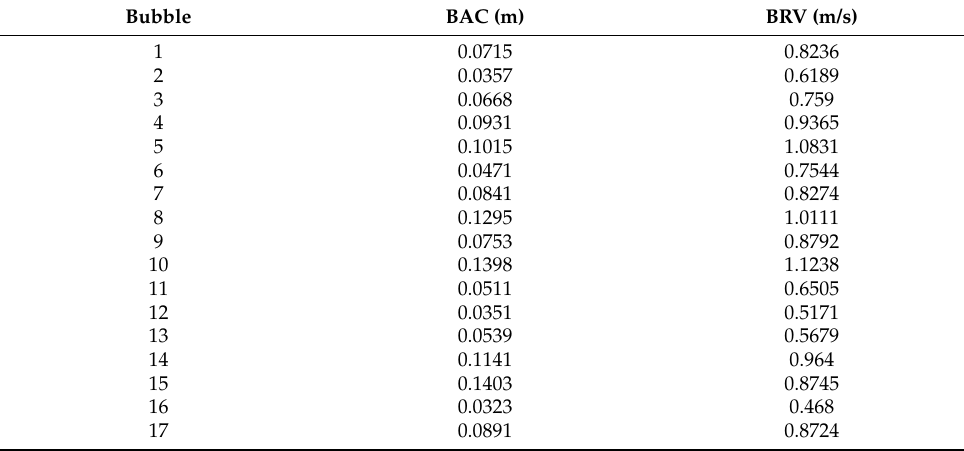
Figure 15. Position of the calculated bubbles using the PPM developed in this study. Calculation 3 at 60 SCFM. Table 6. Identification number for each bubble reported in Figure 15, along with size and velocity of each bubble.